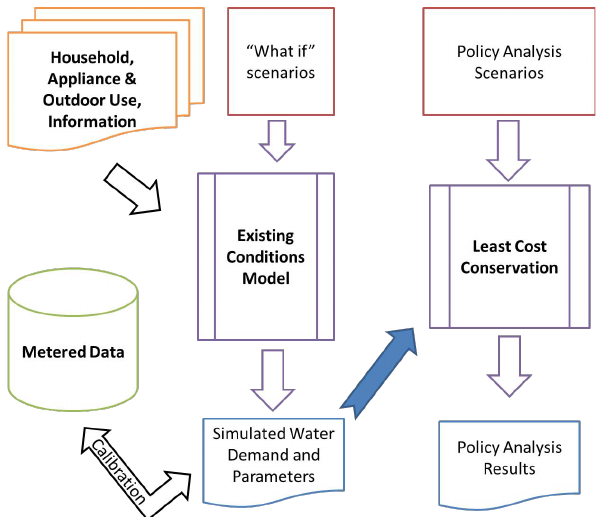
Fig. 1. Modeling framework for economic analysis of water conser-